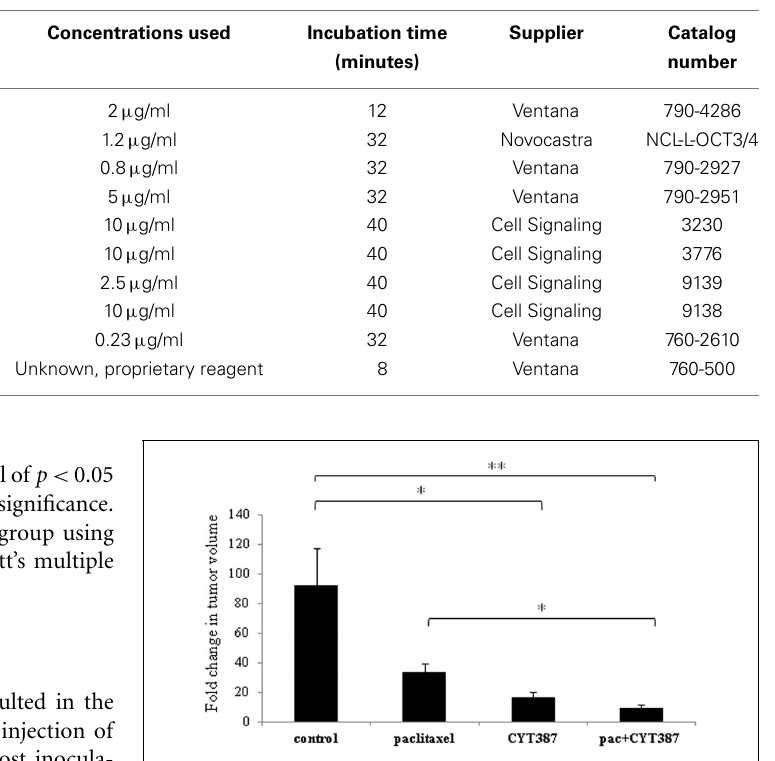
FIGURE 1 | HEY xenograft volume in mice administered with or without paclitaxel, CYT387 or a combination of paclitaxel and CYT387 (pac + CYT387) . Average fold change in subcutaneous tumor volume. Tumors were measured at day 0 (prior to treatment) and at the end of the experiment (day 28). Data have been obtained from n = 5 mice in each group. Significant intergroup variations are indicated by * p < 0.05, ** p <